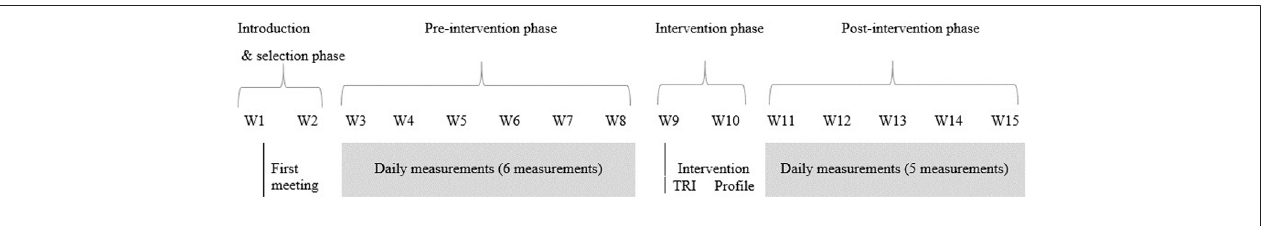
FIGURE 1 | Overview study (week 1 – week